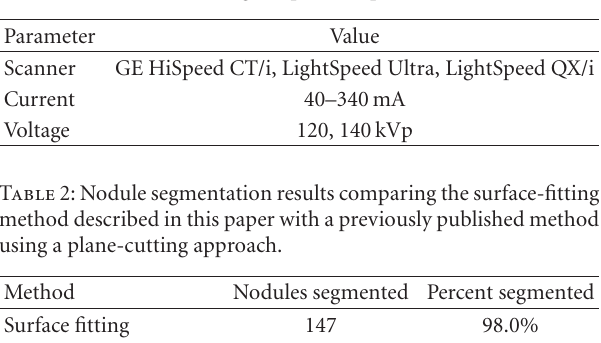
Table 1: Image acquisition parameters.